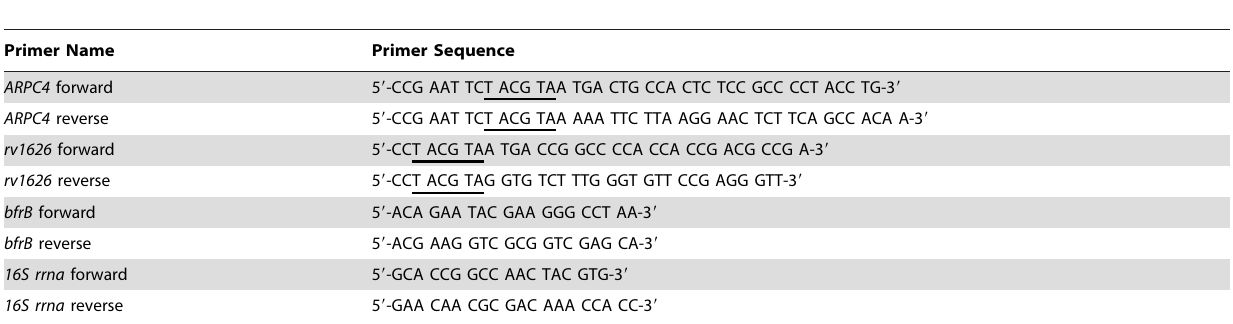
Table 1. Sequences of the DNA primers used for PCR amplification of various genes described in the present